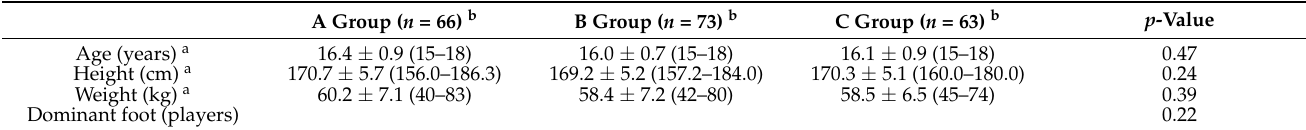
Table 2. Subject Characteristics ( n =